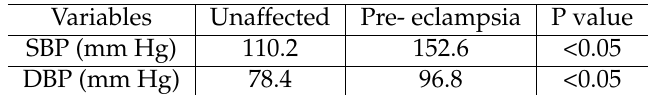
Table 1. Distribution of patients based on blood pressure parameters